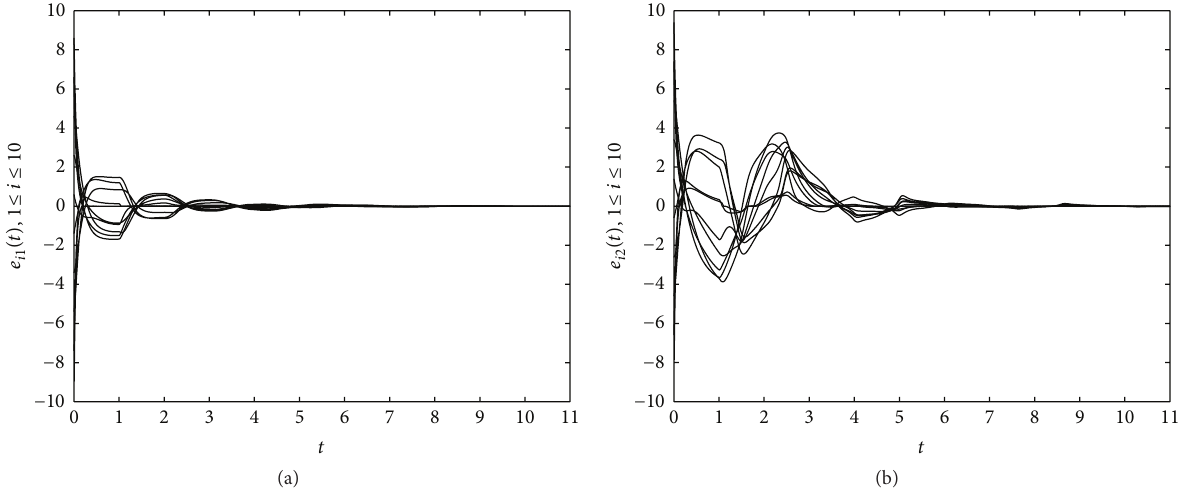
Figure 8: Synchronization errors of (52): (a) 𝑒 𝑖1 , (b) 𝑒 𝑖2 , 1 ≤ 𝑖 ≤ 10